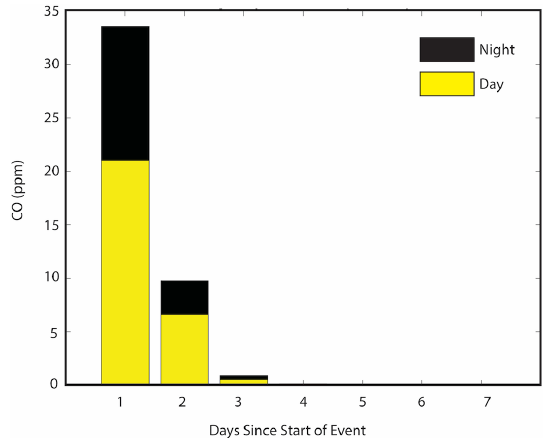
Figure 3. Distribution of transit times representing the difference between the time when CO was emitted by a fire and the time the CO anomaly reached the CRV tower, as estimated by multiplying footprints from PWRF-STILT with fire emissions from AKFED. Only times when fire emission ratios were calculated were used in the